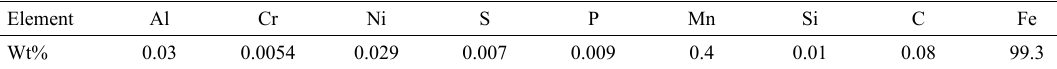
Table 1. Chemical composition of St37 samples used as sub-layer.